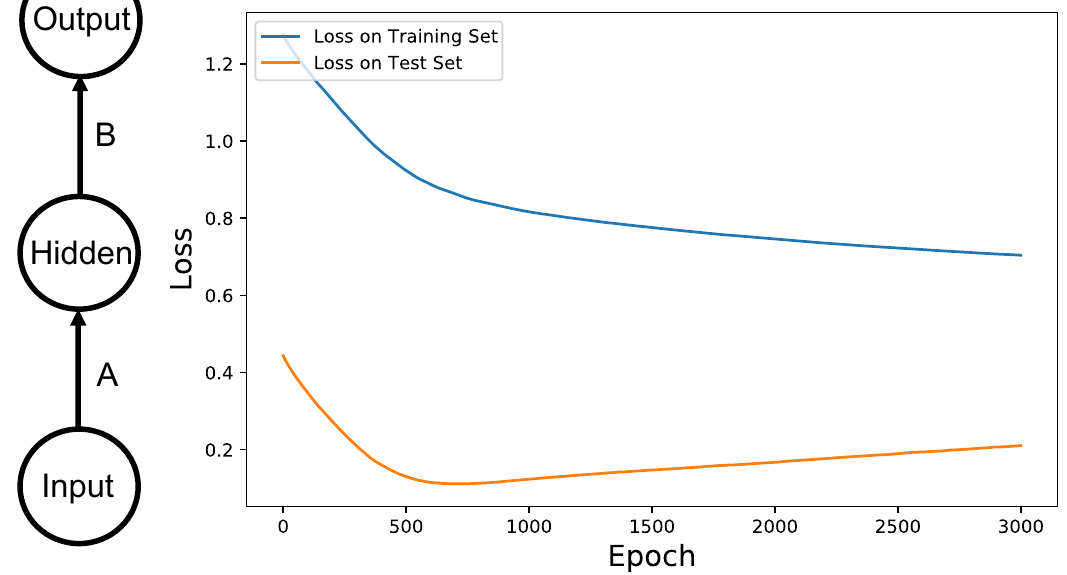
Figure 4. Topology of a simple 3-layer feed-forward Neural Network ( left ) and loss on the training and test set of an exemplary training run for hourly time resolution ( right